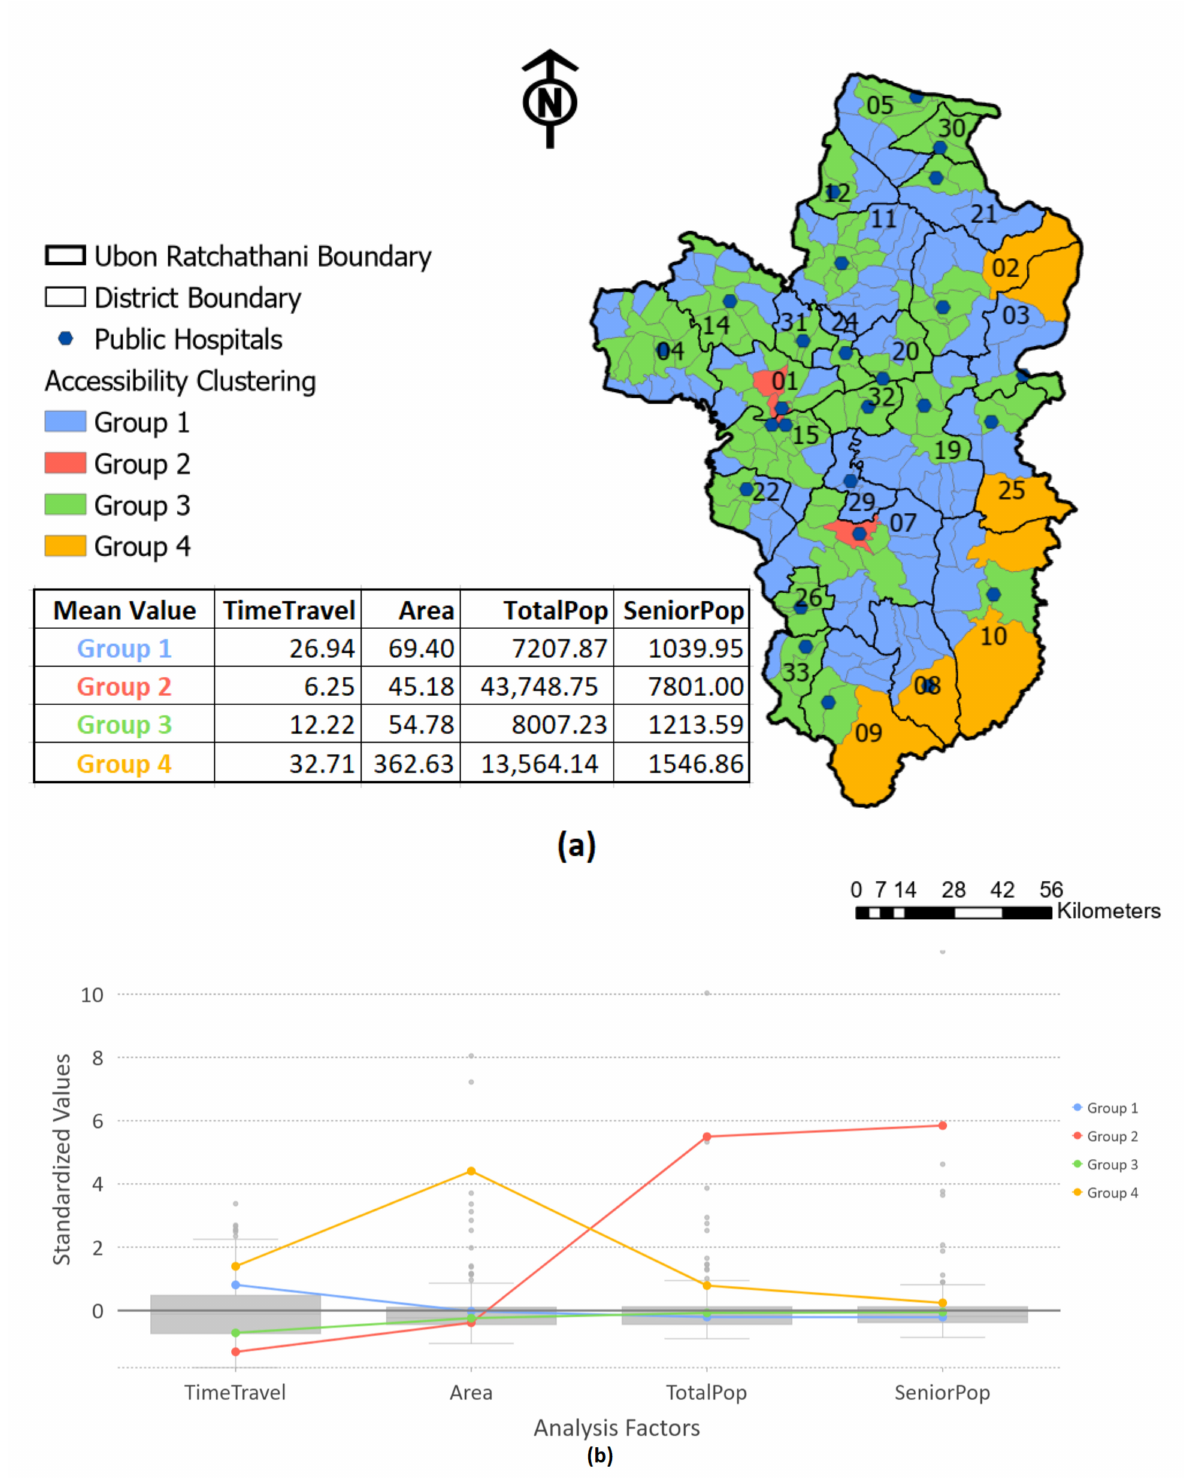
Figure 8. Spatial clustering analysis based on travel duration, covered area of each sub-district, total population within the area and demand of the senior population: ( a ) four groups of classification in Ubon Ratchathani; ( b ) box-plot of the clustering comparing the distributions of different data